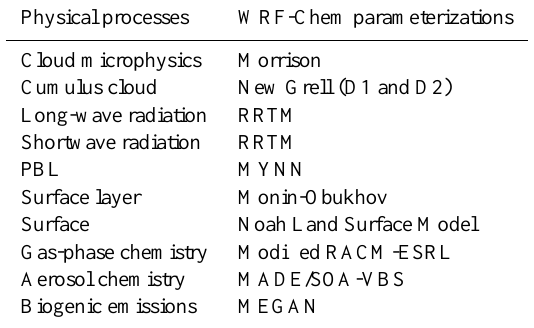
Table 1. Physical and chemical parameterizations used in the simu-